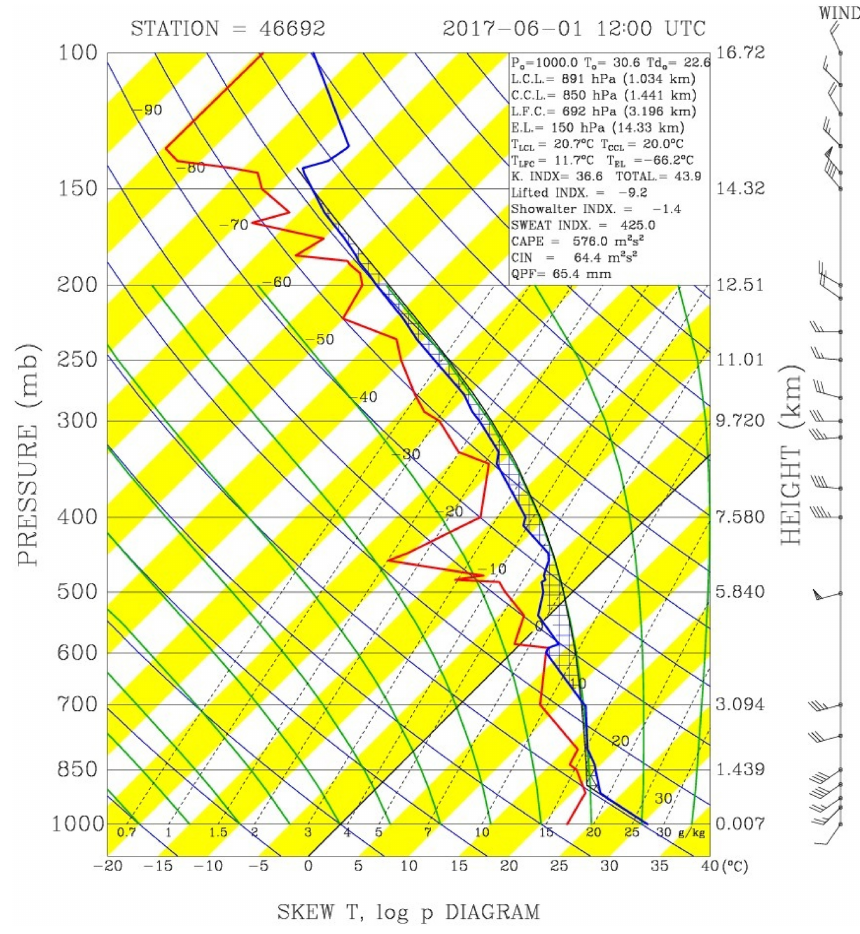
Figure 4. The sounding and horizontal wind profiles at Panchiao, Taipei (46692), launched at 12:00UTC on 1 June 2017. Some relevant parameters are given at the top